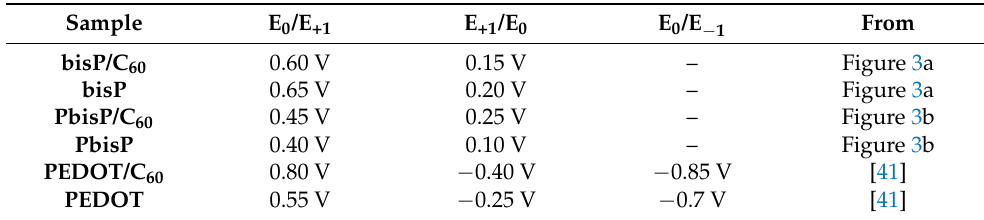
Table 1. Anodic and cathodic bands corresponding to the bisP homopolymer and PbisP copolymer in absence and presence of fullerene C 60